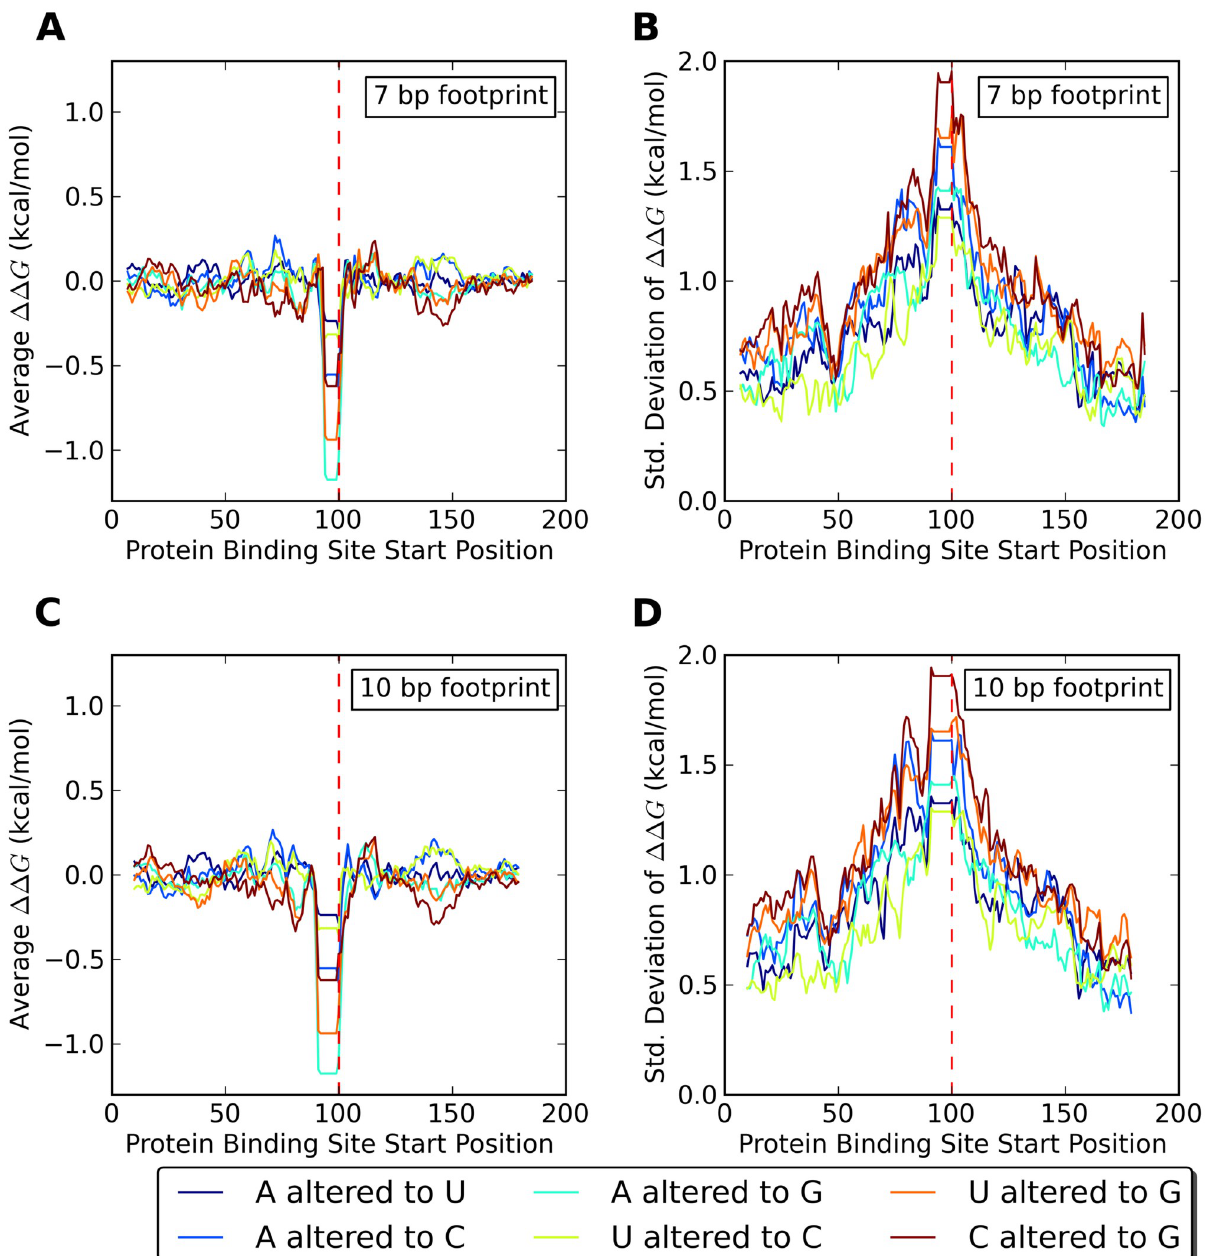
Fig 1. Effect of SNPs in random 201 nucleotide sequences on protein binding. (A) and (C) Averages and (B) and (D) standard deviations for the change in effective RNA-protein binding free energy, ΔΔ G , in response to six different single nucleotide sequence alterations averaged over 100 randomly chosen RNA sequences. (A) and (B) show data for a protein with a 7 bp footprint and (C) and (D) for a protein with a 10 bp footprint. The sequence alteration location (indicated by the dashed vertical red line) is static while the protein binding site start position is